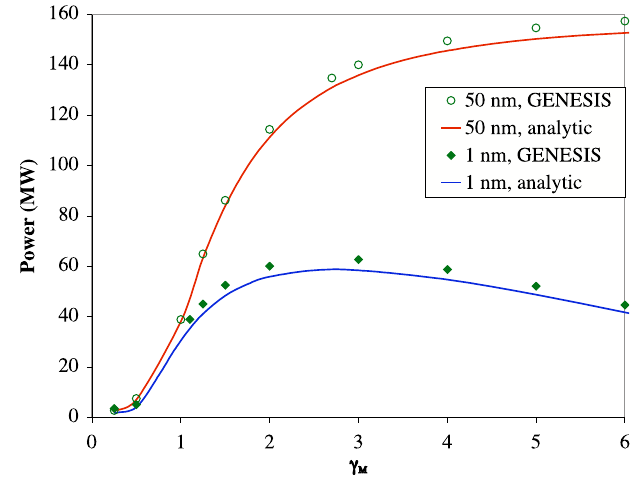
FIG. 2. (Color) Comparison of analytic theory with simulations using GENESIS . Results are shown for harmonic generation at 50 and 1.04 nm, as the energy modulation (cid:3) reoptimized.